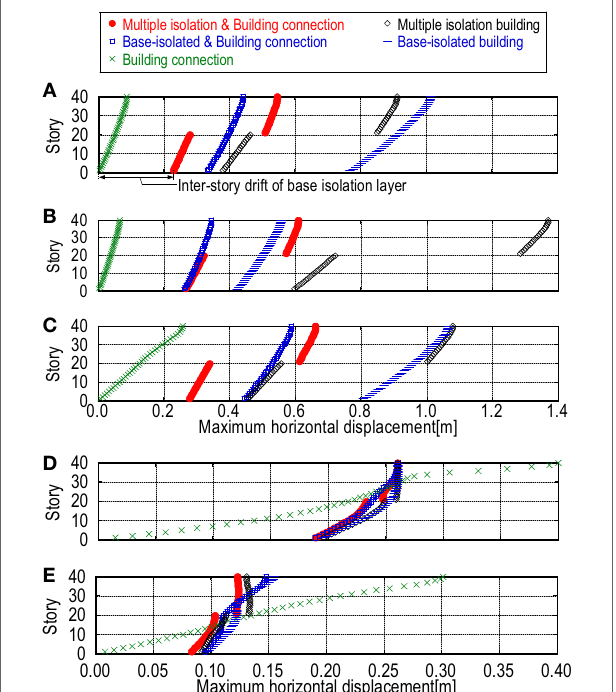
FIGURE 8 | Maximum horizontal displacements under various ground motions: (A) artificial long-period, long-duration ground motion (6.8s), (B) artificial long-period, long-duration ground motion (8.4s), (C) Tomakomai EW (2003), (D) artificial pulse-type ground motion, and (E) JMA Kobe NS (1995)